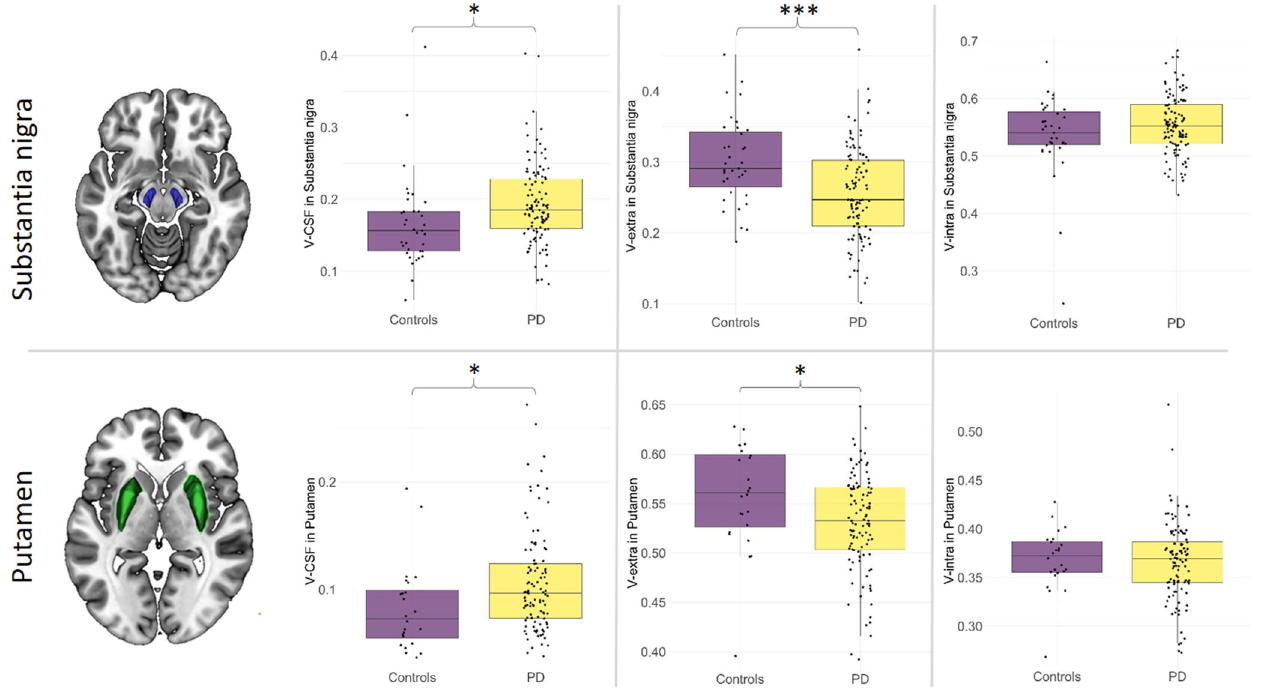
Fig. 3 ROI-based group comparison of nigral and putaminal microstructure between patients with PD and healthy controls. Group comparisons of microstructural compartments (V-extra, V-CSF, V-intra) in the SN ( top row ) and putamen ( bottom row ) between PD and HC groups. Dots represent individual subject values, while boxplots show group median, quartiles, minimum and maximum values. Signi fi cance threshold: * p < 0.05, *** p < 0.001. PD Parkinson ’ s